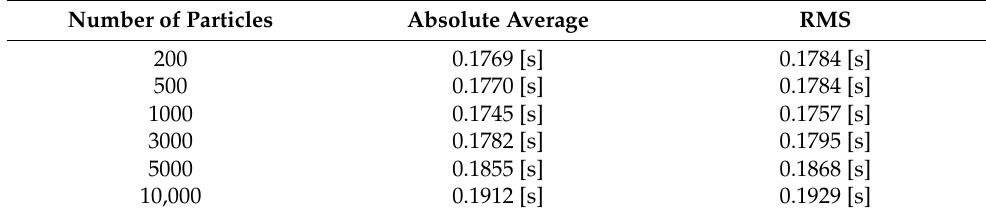
Figure 8. ( a ) Cycle loop time by number of particles; ( b ) average and RMS of cycle loop time. Table 3. Absolute average and RMS of cycle loop time.